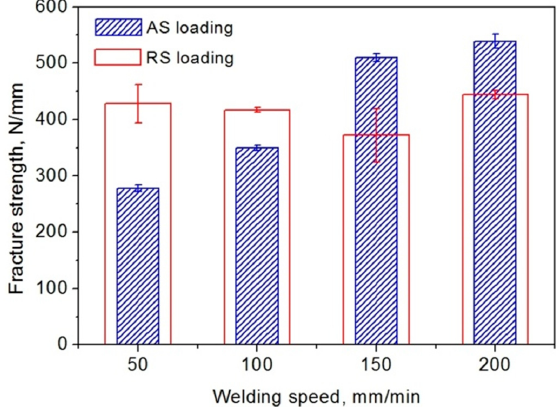
Figure 8. Fracture strength of the lap joints obtained at different welding speeds.